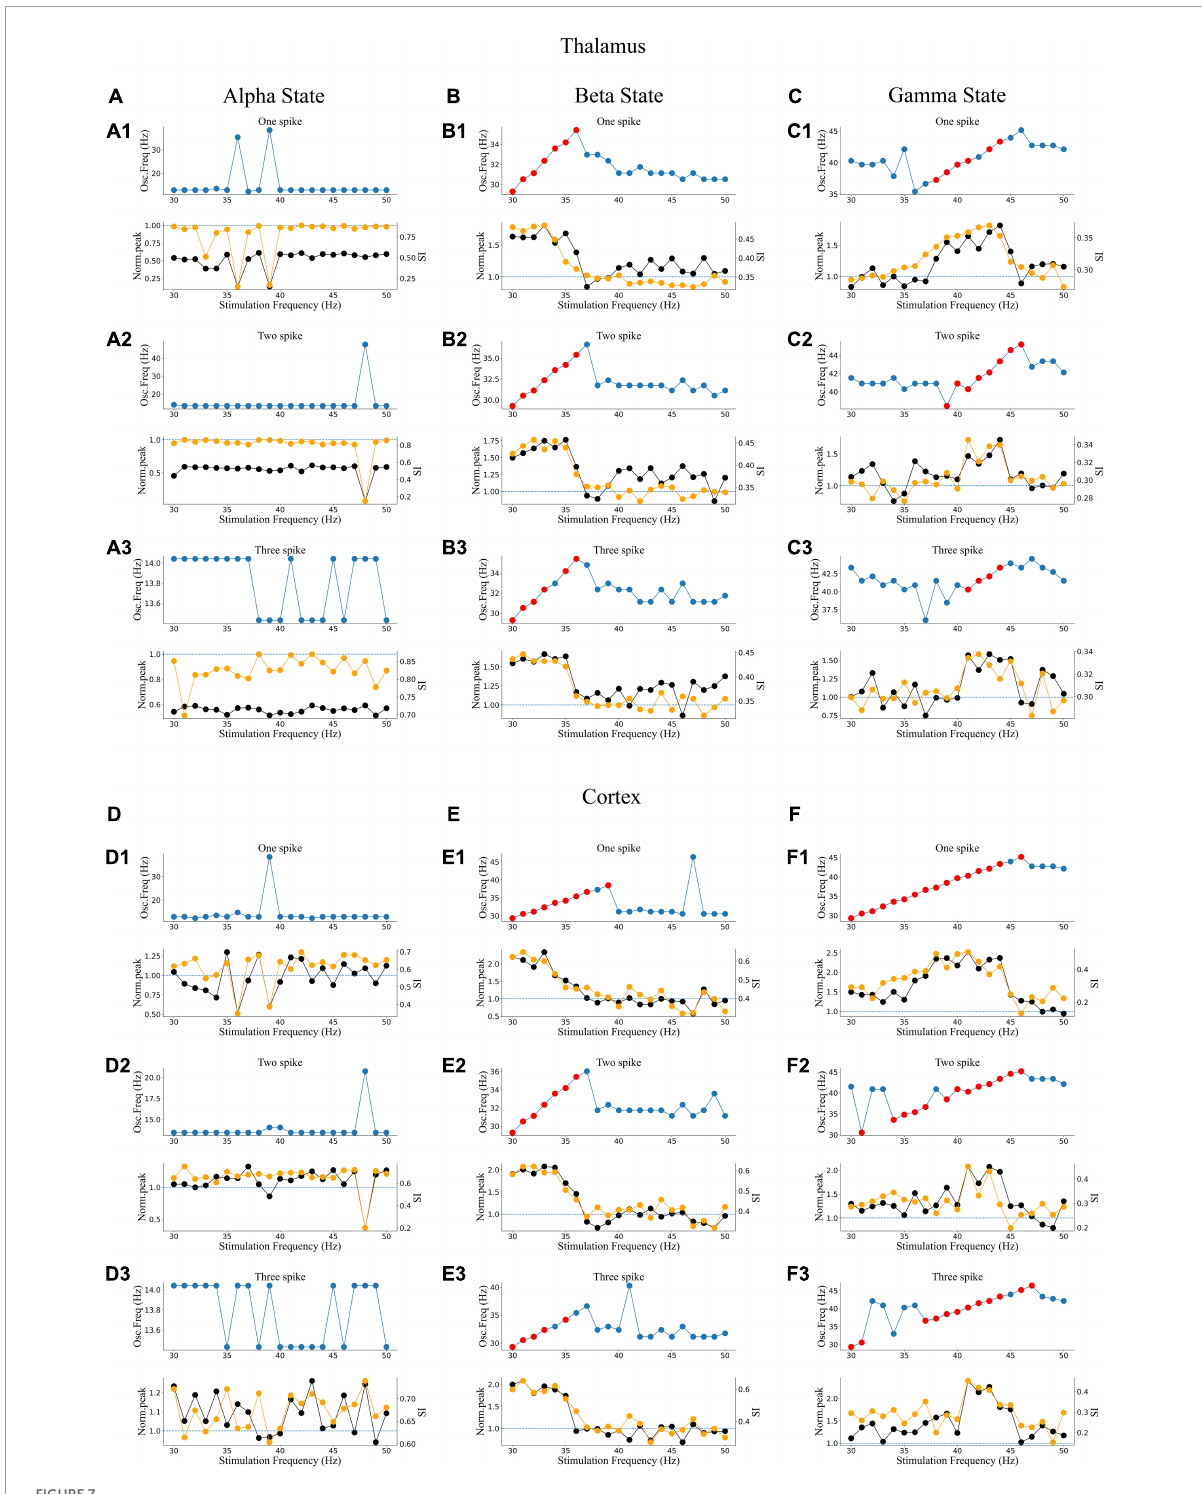
FIGURE7 Oscillatory dynamics modulated by gamma flicker. (A) Effect of stimulation on the network dynamics of the alpha oscillatory state for the thalamus. Top: Dominant network oscillation frequency; Bottom: Normalized spectral peak (black) along with SI (orange) as a function of stimulation frequency (30–50 Hz) in the presence of three levels of stimulation intensity (A1–A3: one, two, and three spikes, respectively). (B,C) The beta and gamma oscillatory states of the thalamus, respectively. (D–F) The alpha, beta, and gamma oscillatory states of the cortex,